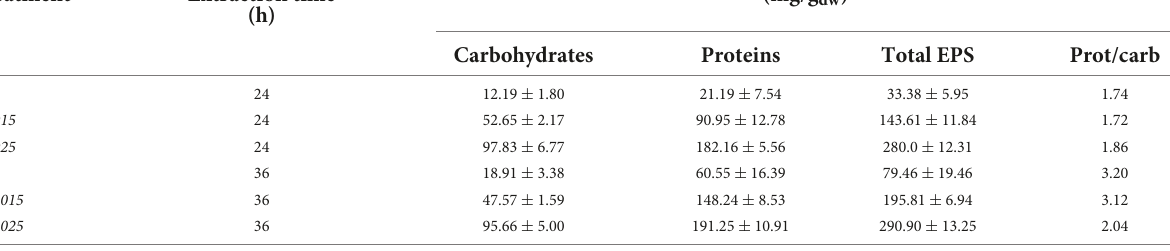
TABLE 2 Carbohydrates and proteins composition of the extracellular polymeric substances. Treatment Extraction time (h)